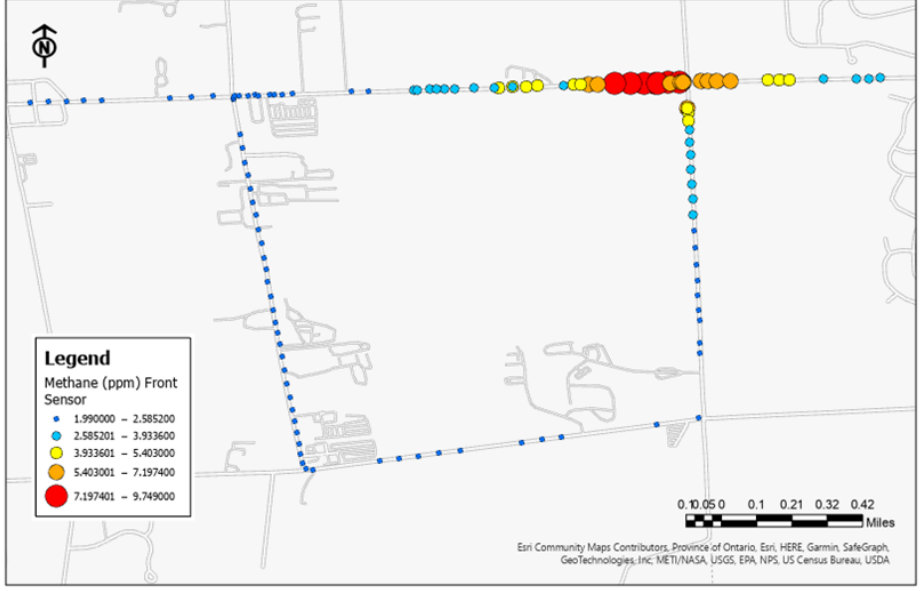
Figure 3. CH 4 concentrations (ppm) measured by MPAL on 5 June 2021, 7:10 a.m. to 7:27 a.m. The best model performance was obtained when total emissions were set to 500 kg/h.